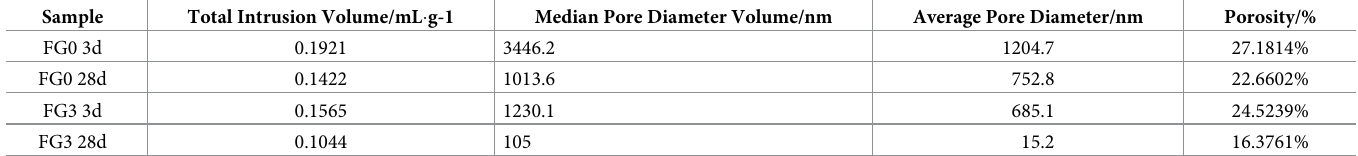
Table 4. Summary of MIP test